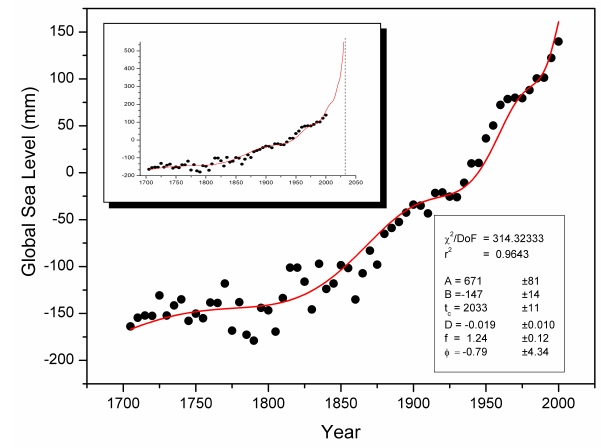
Fig. 1. Extension of the SAA over the last 400yr and the best non- linear fit of the function indicated in the text as Eq. (5). The “critical time” t c would be 2034 ± 3yr, where the curve will have a singular- ity, i.e., where the curve is tangent to the vertical dashed line drawn at the critical time in the smaller picture. Our interpretation is that this time will represent the time of no return for a great change in the geomagnetic field, possibly going toward a reversal or excursion. In the inset table, DoF are the degrees of freedom and r is the correla- tion coefficient of the nonlinear fit; for the other fitting parameters see the text.